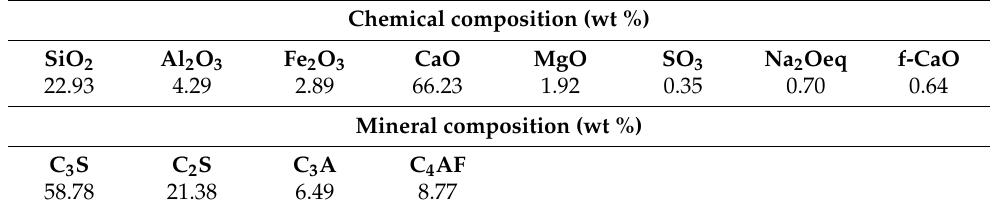
Table 1. ISO standard sand was produced by Xiamen ISO Standard Sand Co., Ltd. (Xiamen,